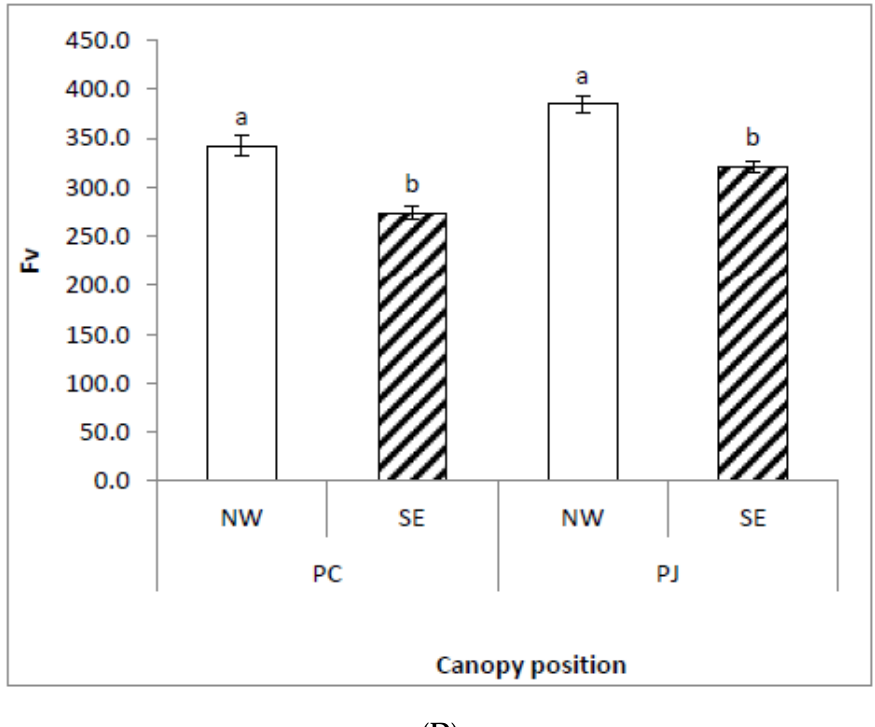
Figure 1. Changes in chlorophyll fluorescence parameters ( A ) F o , ( B ) F m , ( C ) F v /F m , and ( D ) F v in Prosopis juliflora and Prosopis cineraria from two different canopy positions (south east, SE; north west, NW). Each bar in a graph represents the mean (±S.E.) of three replicates. Means with the same letters within a species indicate insignificant difference between the two canopy positions at p >0.05 according to Duncan Multiple range test. Table 1. Field site surveyed in this study area was Muntaza Desert, at Sharjah Emirates and climate data (2018) are mean annual of interpolated data obtained from online portal of IWMI (International Water Management Institute) (http://wcatlas.iwmi.org/Default.asp).